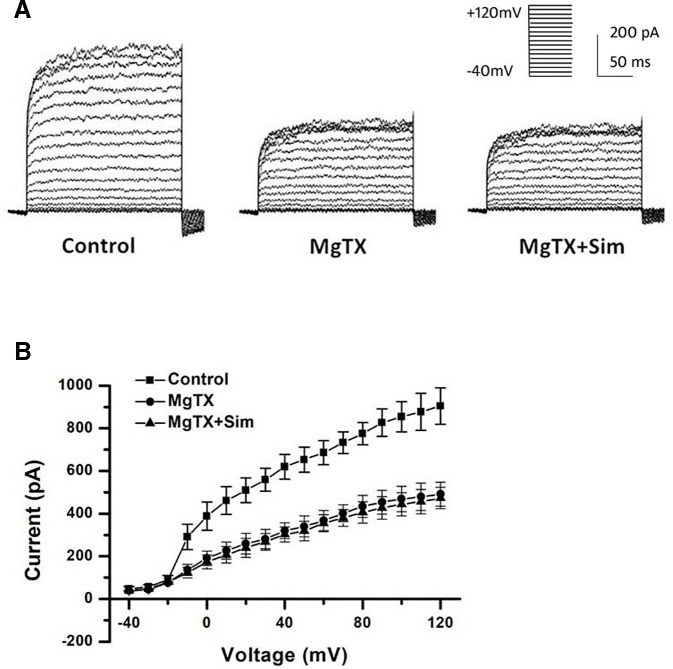
Simvastatin sensitive components of KCa3.1 current recording above −40 mV was identified in THP-1 cells measured by whole-cell clamp patch. (A) The THP-1 cell was held at −40mV and received the test potentials from −120 to +40 mV; the currents were detected by using an electrode with 1 µM free Ca2+. (B) Average current density-voltage relationships before and after application of 1 nM MgTX and 10 µM simvastatin was indicated (n = 4 for each group).